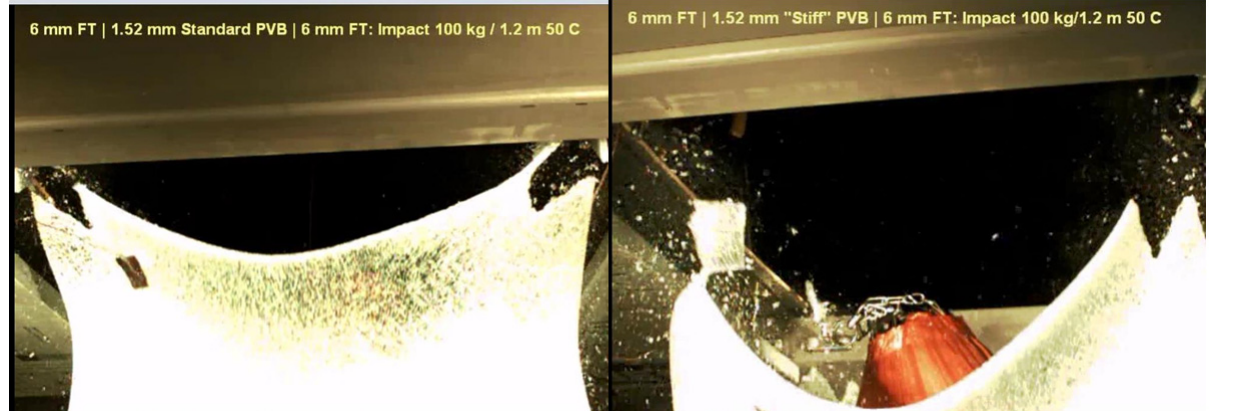
Fig. 5 Standard PVB laminate provided no “Fall Through” resistance, view from below just after the impact, see failure of the laminate